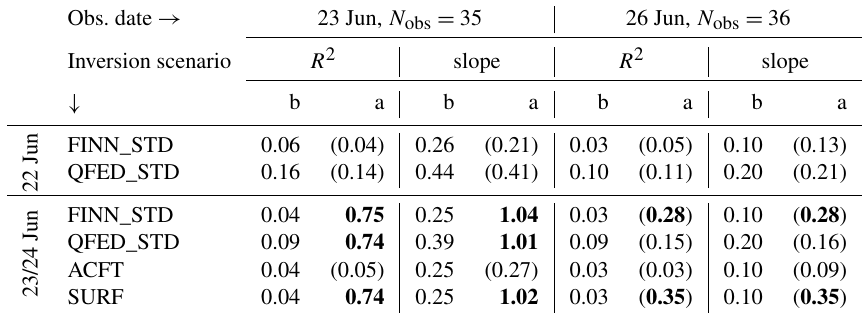
Table 3. Surface observation linear regression characteristics for the prior (background, b) and posterior (analysis, a).